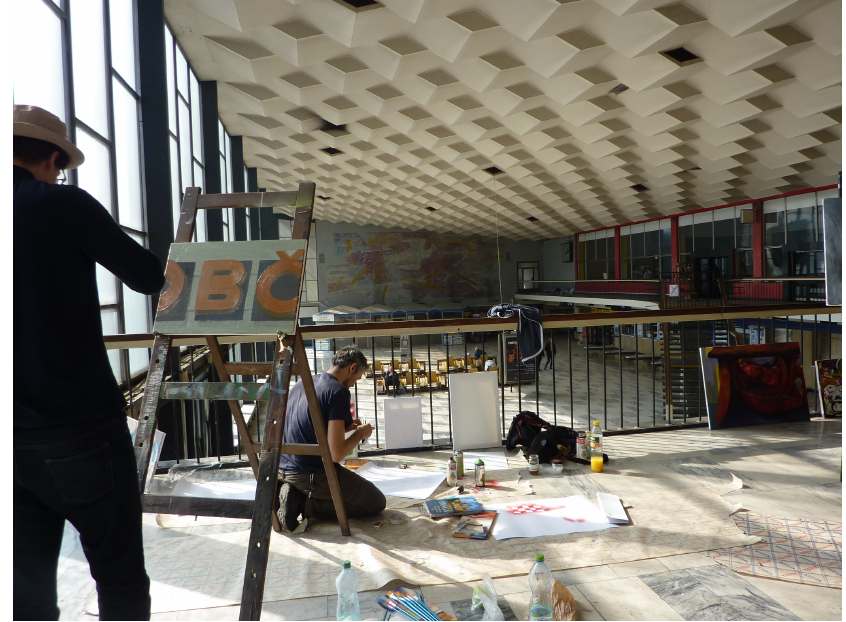
Figure 3. Workshop at Havířov railway